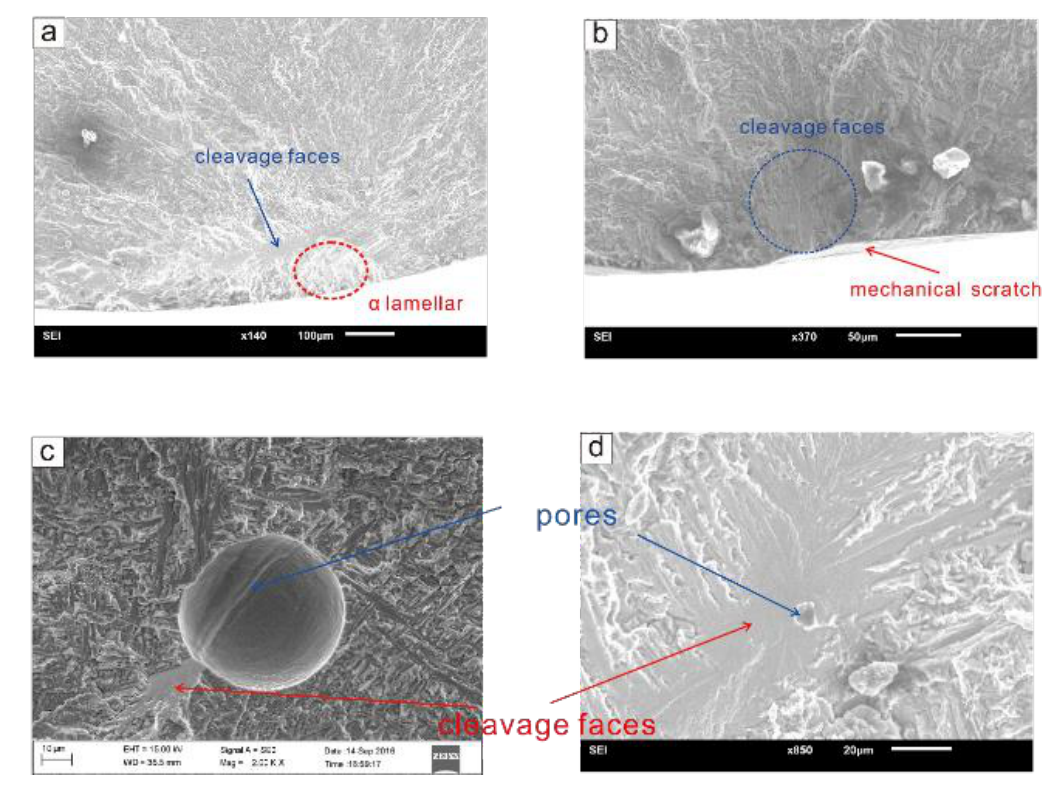
Figure 5. Details of CIS of ( a , b ) SIS; ( c , d ) SII.